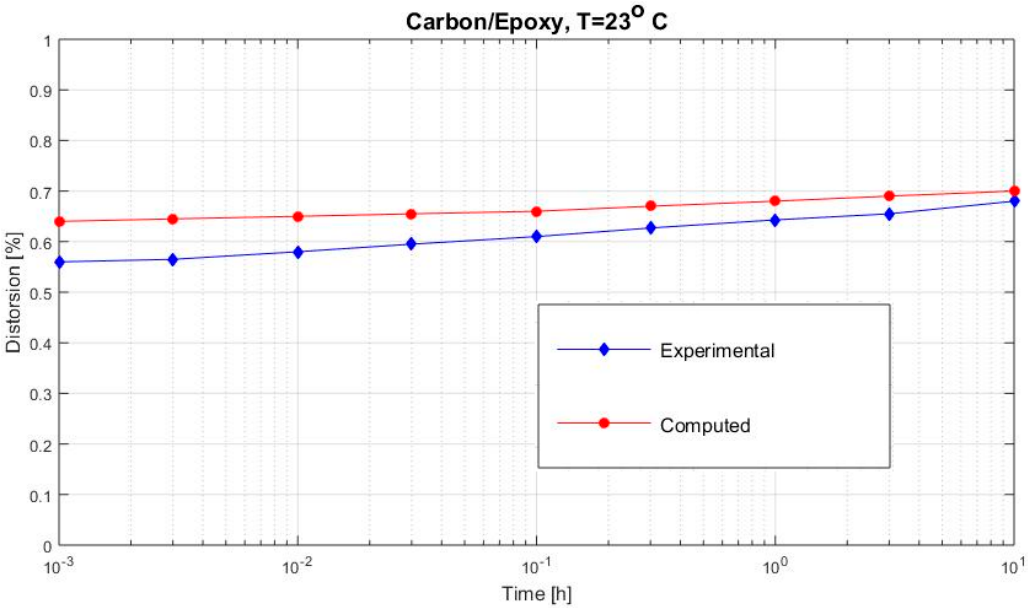
Figure 10. Creep distortion γ 12 (carbon / PEEK subjected to τ 12 = 6 MPa at 100 ◦ C).